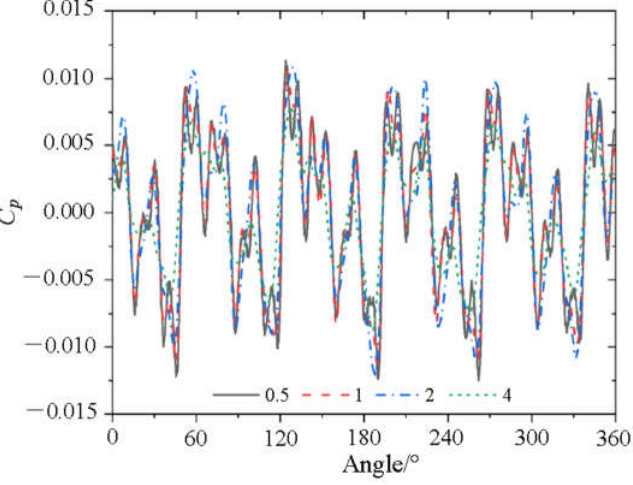
Figure 5. Surface mesh of the impeller: ( a ) leading edge and ( b ) trailing edge.